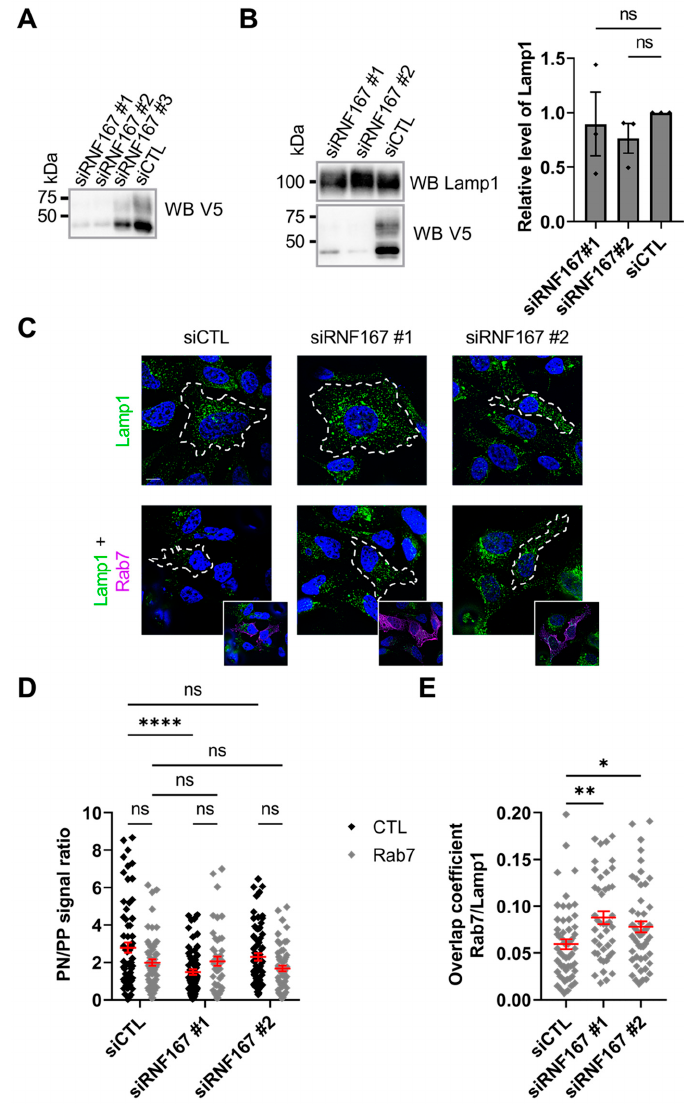
Figure 5. Rab7 lysosome positioning is independent of RNF167 abundance . ( A ) RNF167 DsiRNA knockdown efficiency was evaluated by the co-transfection of selected DsiRNF167 with RNF167- V5-His in HeLa cells. Cell lysates were probed with a V5 antibody against exogenous RNF167-V5- His. Blot is representative of results from three independent experiments. ( B ) RNF167 depletion does not alter endogenous Lamp1 protein abundance ( left ). Blots are representative results of three independent experiments. The stain-free signal (not shown) was used to normalize protein for quantitative analysis of Lamp1 abundance ( right ). siCTL = control DsiRNA. Non-parametric one-way ANOVA with Kruskal–Wallis post-test was used, ns = non-significant. ( C – E ) Impact of RNF167 expression on Rab7 lysosomal positioning. ( C ) Co-transfection of DsiRNF167 or its control in the presence or absence of 2xHA-Rab7. HeLa cells were fixed and labelled for the HA-tag of Rab7 (purple), endogenous Lamp1 lysosome marker (green) and DAPI (blue) for the nucleus. Scale bar = 10 µ m. Images are representative results of three independent experiments. ( D ) Quantitation of perinuclear-to-peripheral Lamp1 signal ratio as explained in material and meth- ods. PN = perinuclear, PP = peripheral. Data from three independent experiments totaling n = 46 to 71 cells. Errors bars (red) represent mean ± SEM. Two-way ANOVA with Tukey’s post hoc test was used, ns = non-significant, ****, p < 0.0001. ( E ) Manders’ overlap coefficient between Rab7 and Lamp1. Errors bars (red) represent mean ± SEM. Non-parametric one-way ANOVA with Kruskal–Wallis post-test was used. n = 44 to 56 cells over three independent experiments, *, p = 0.0334, **, p =